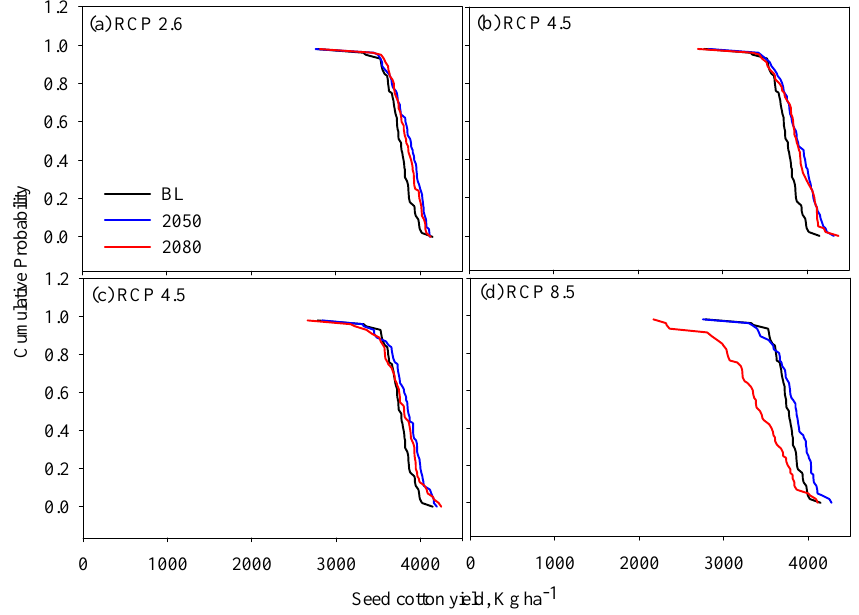
Figure 5. Simulated impacts of climate change (changes in temperature, rainfall, and CO 2 ) on irrigated seed cotton yield in 2050 and 2080 under the four emission scenarios of RCP 2.6 ( a ), 4.5 ( b ), 6.0 ( c ), and 8.5 ( d ).